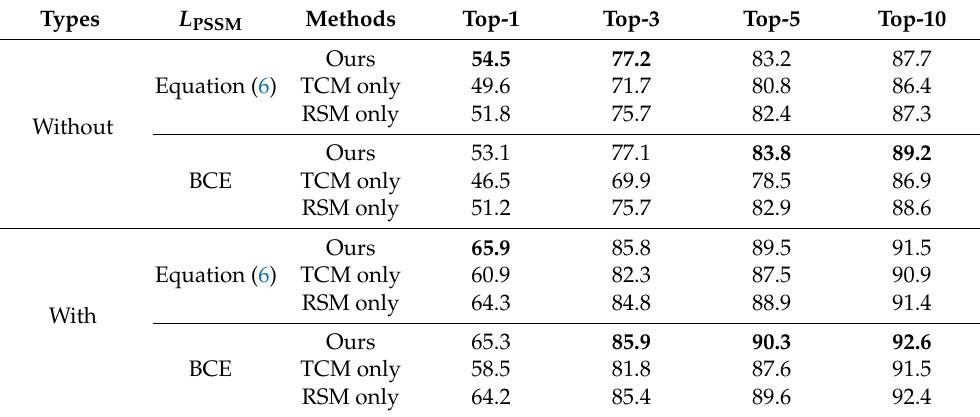
Table 2. Ablation study results (%) of two different PSSM loss functions: our proposed Equation (6) and BCE. The bold indicates the best